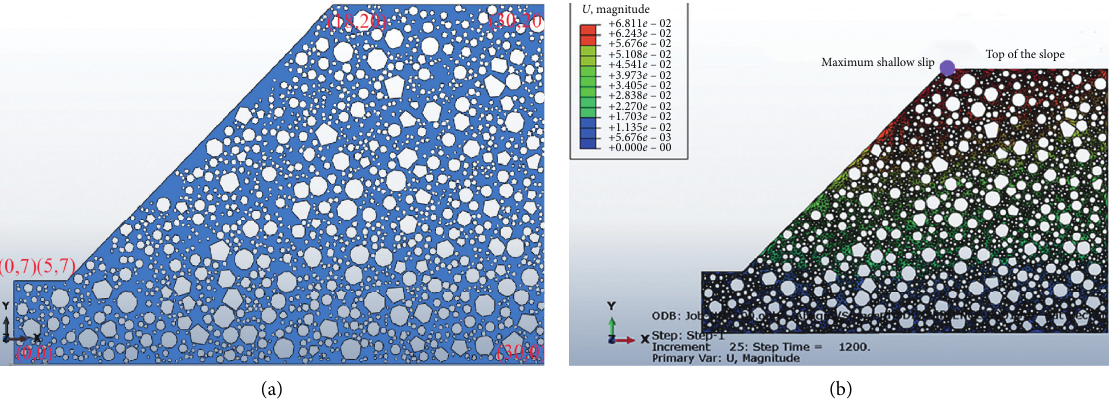
Figure 12: Soil-rock mixture slope in ABAQUS. (a) The slope model in ABAQUS and (b) the shallow slip of the slope after 150 freeze-thaw cycles.